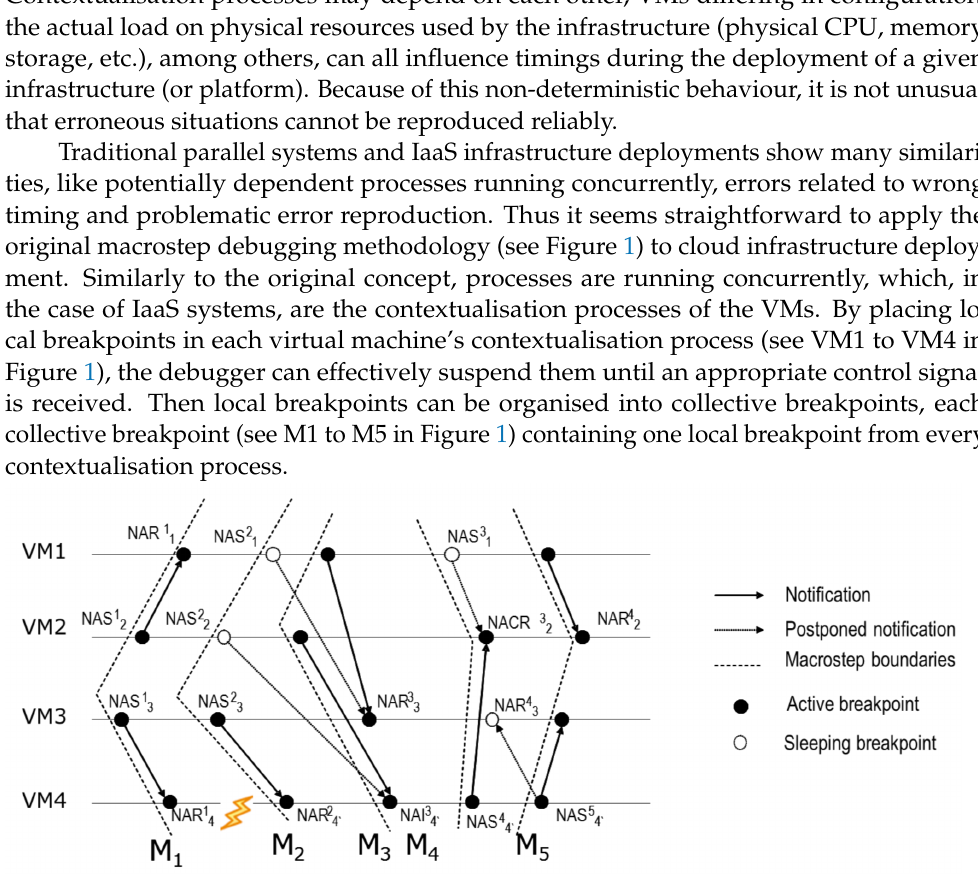
Figure 1. Macrostep concept in IaaS cloud